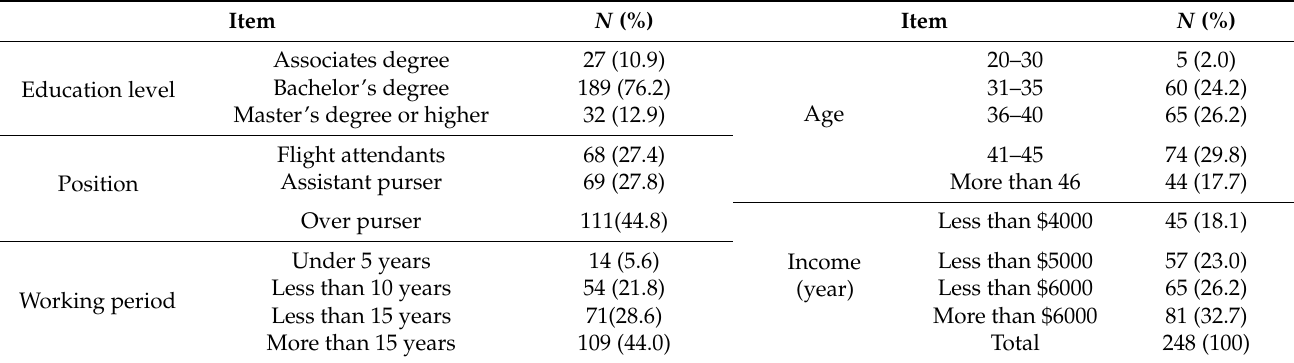
Table 1. Demographic Characteristics of Survey Subjects.